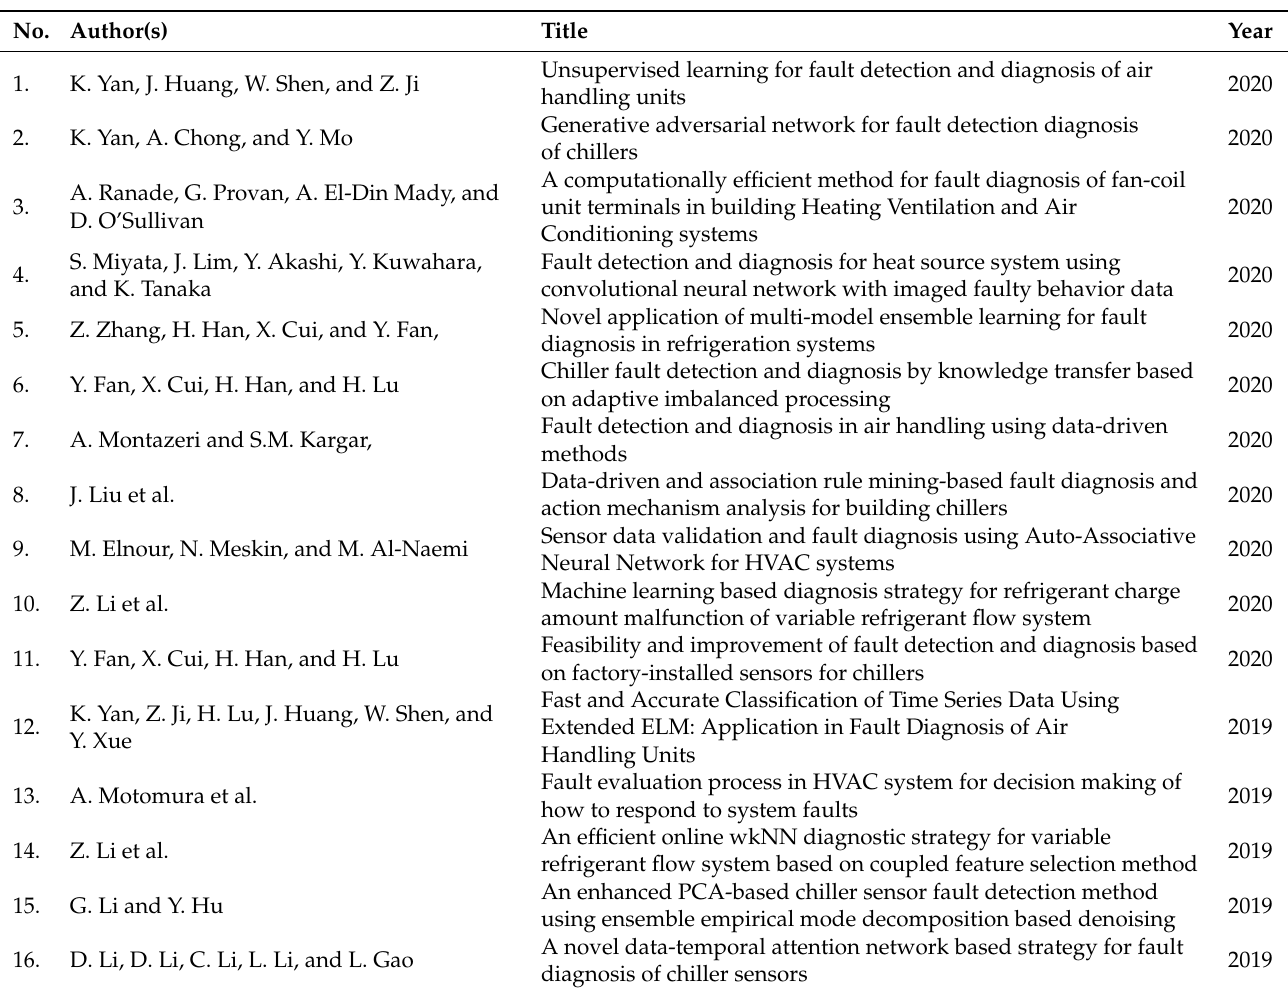
Table A1. List of the 82 studies considered for